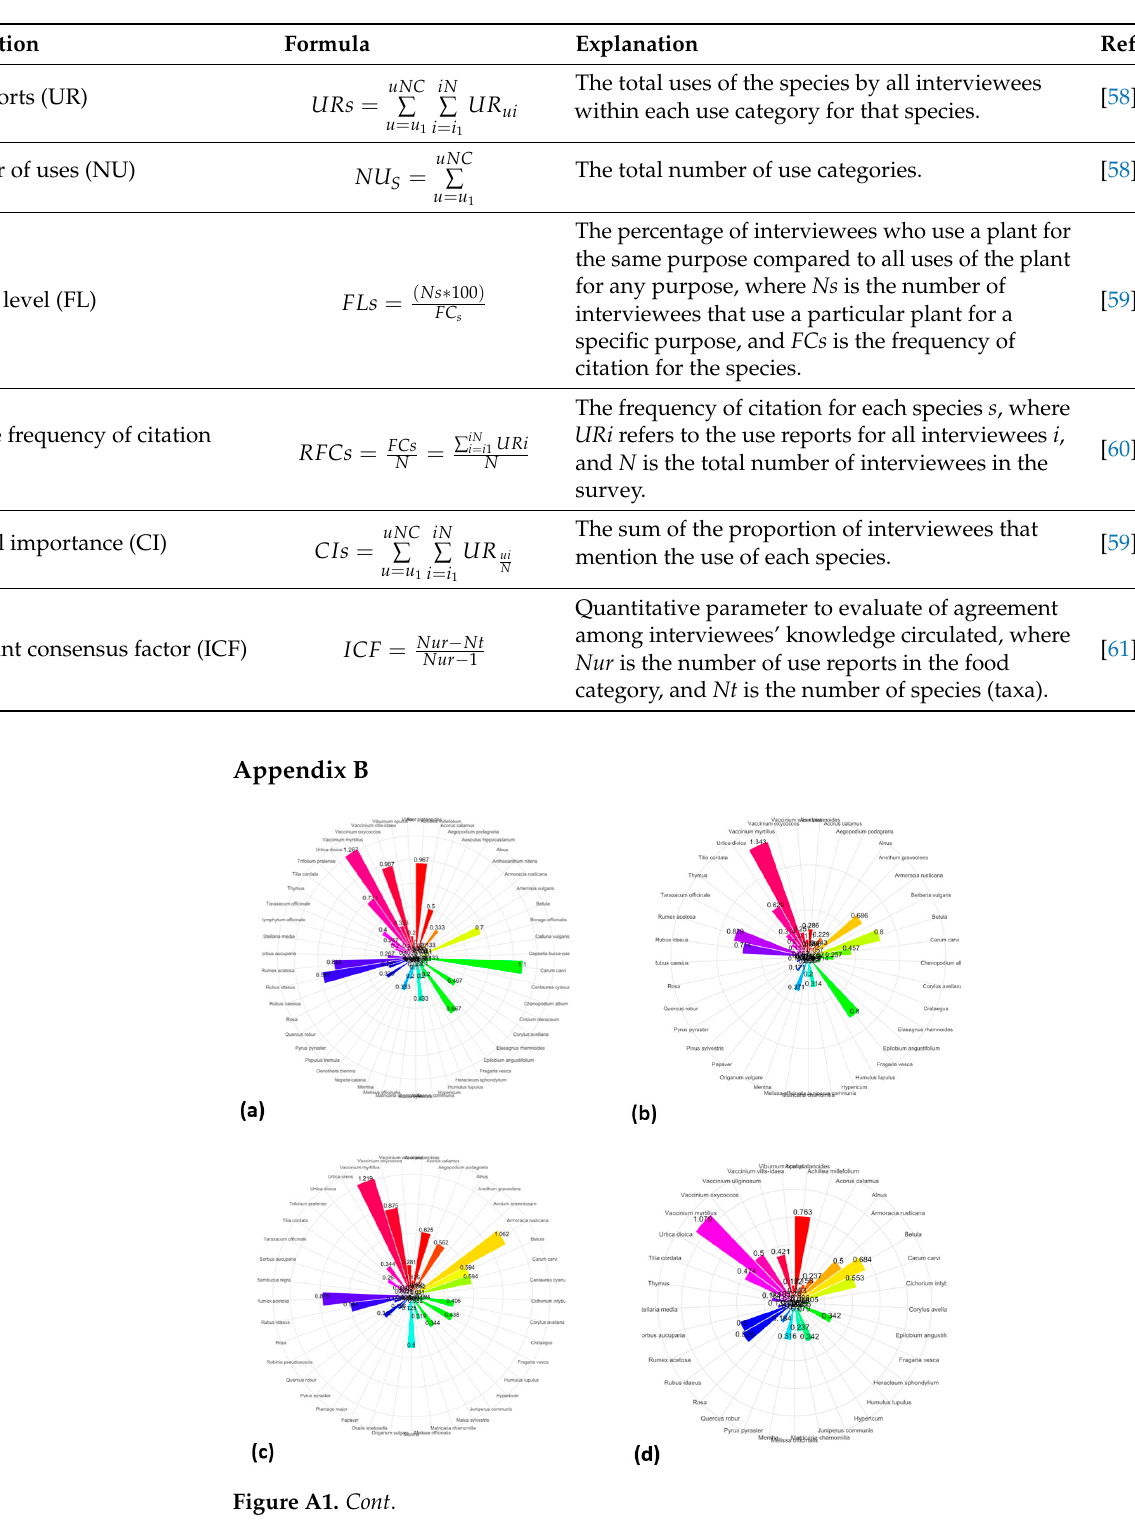
Figure A1. Radial plots of cultural importance (CI) index values for the case studies: ( a ) BYLT, ( b ) BYPL, ( c ) LTLT, ( d ) LTPL, ( e ) PLLT, and ( f ) PLPL. Analysis performed using EthnobotanyR package in RStudio References 1.